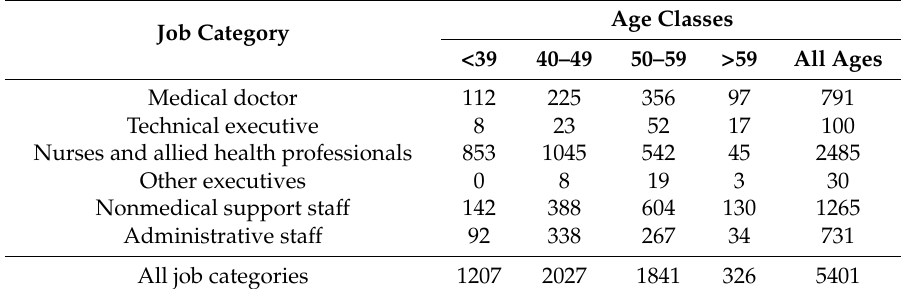
Table 2. Job category and age range distributions of employees (average over three years). Job